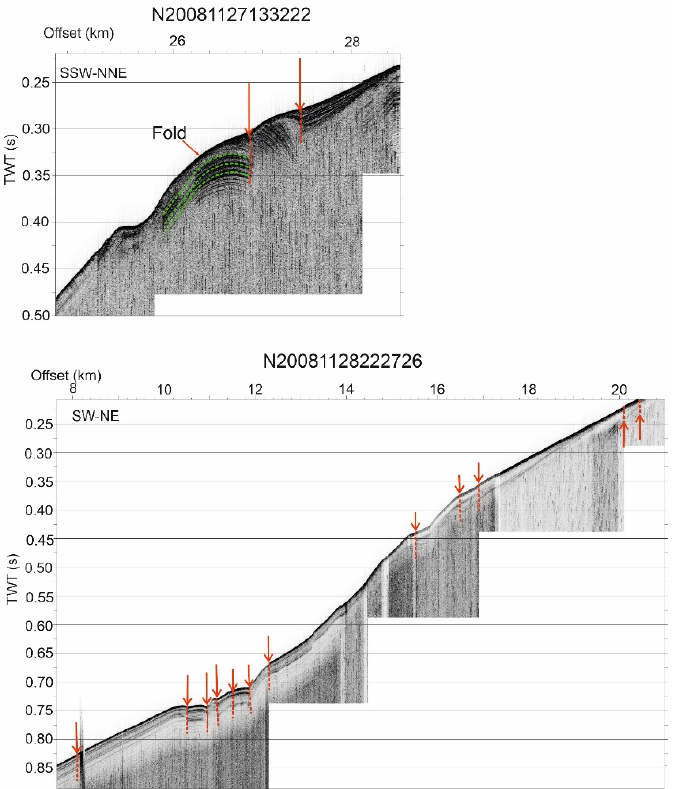
Figure 5. High-resolution reflection profiles west of the Campo de Dalias showing the very recent folds and faults (red arrows). Location in Figure